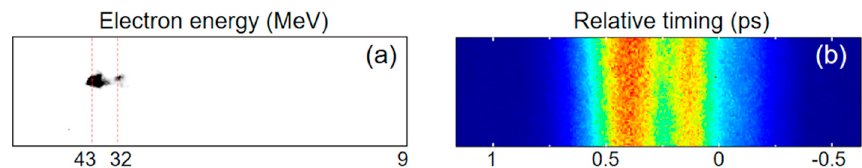
Figure 3. Longitudinal multibunch structure observation by EO spatial decoding in the experiment. ( a ) Electron energy spectrum showing two peaks at 43 and 32 MeV. ( b ) The EO signal in the same shot. There are two timing peaks at +130 and +400 fs.